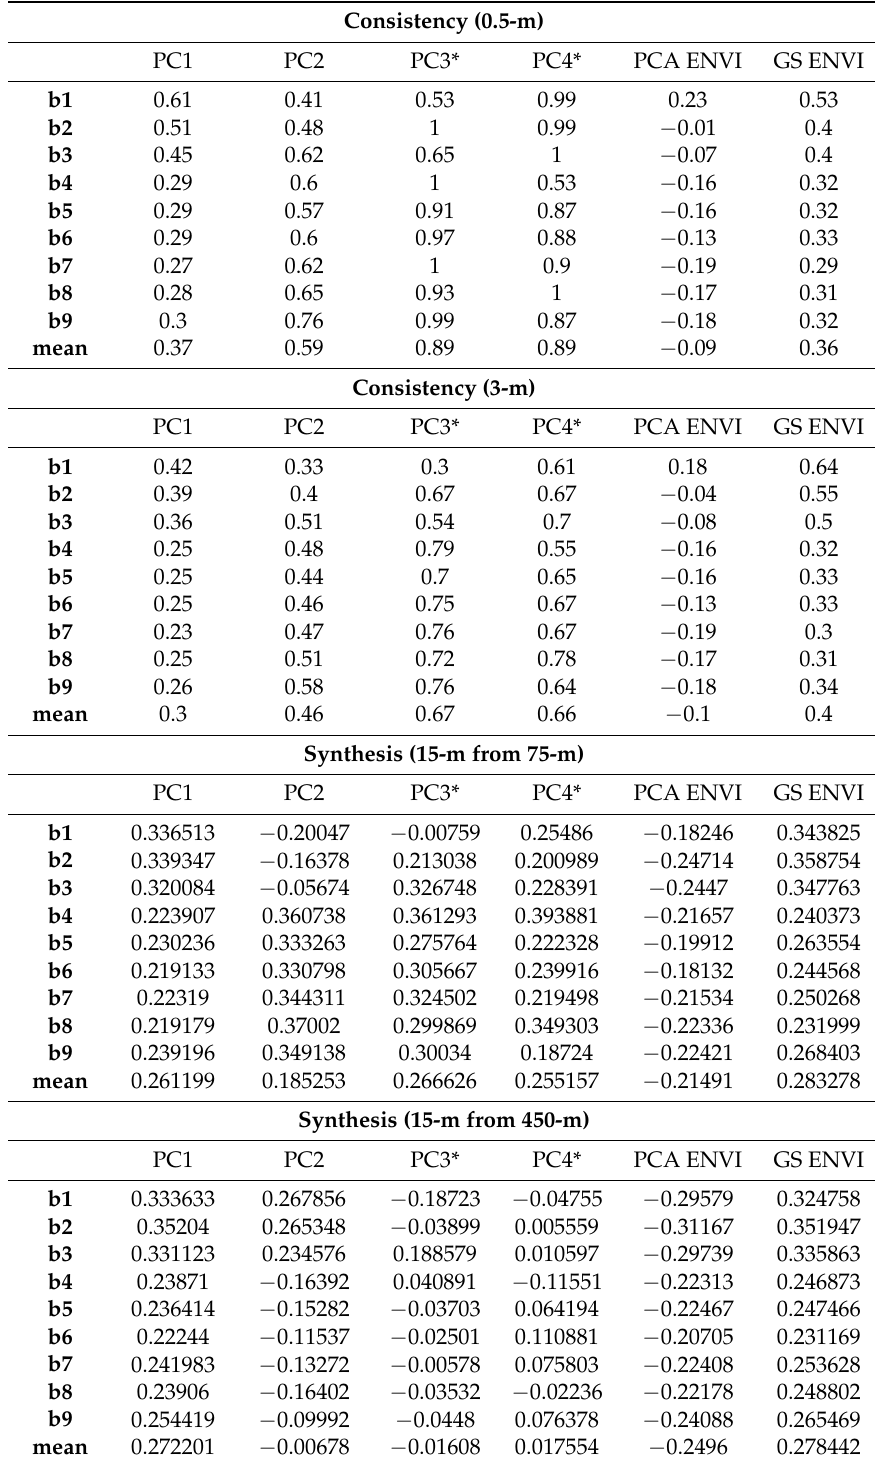
Table 8. Interband UIQI for Aster dataset. Values of the UIQI range from +1 to − 1, while 1 is considered as the best value. PC3* and PC4* were used to compare the result and explain it in a wider